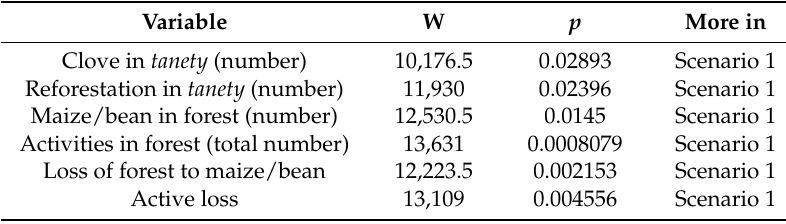
Table A5. Statistical Analysis of Players’ Gaming Behavior and Land-Type Changes. All game variables that showed a statistically significant difference between Scenario 1 and 2 are listed below. A non-parametric Wilcoxon rank sum test with continuity correction was used with the R software version